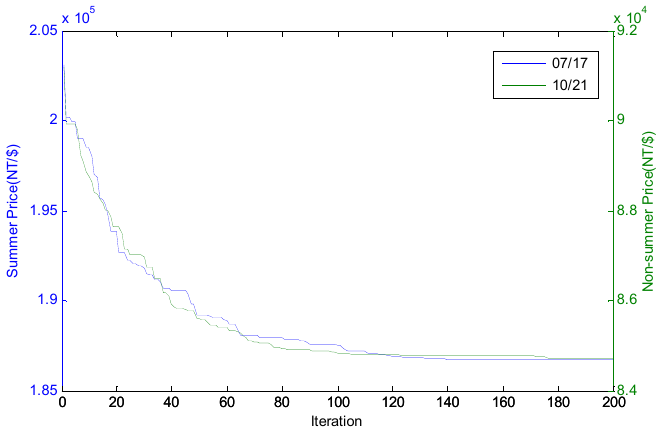
Figure 10. Convergent characteristics of operating cost on a summer day and non-summer day.